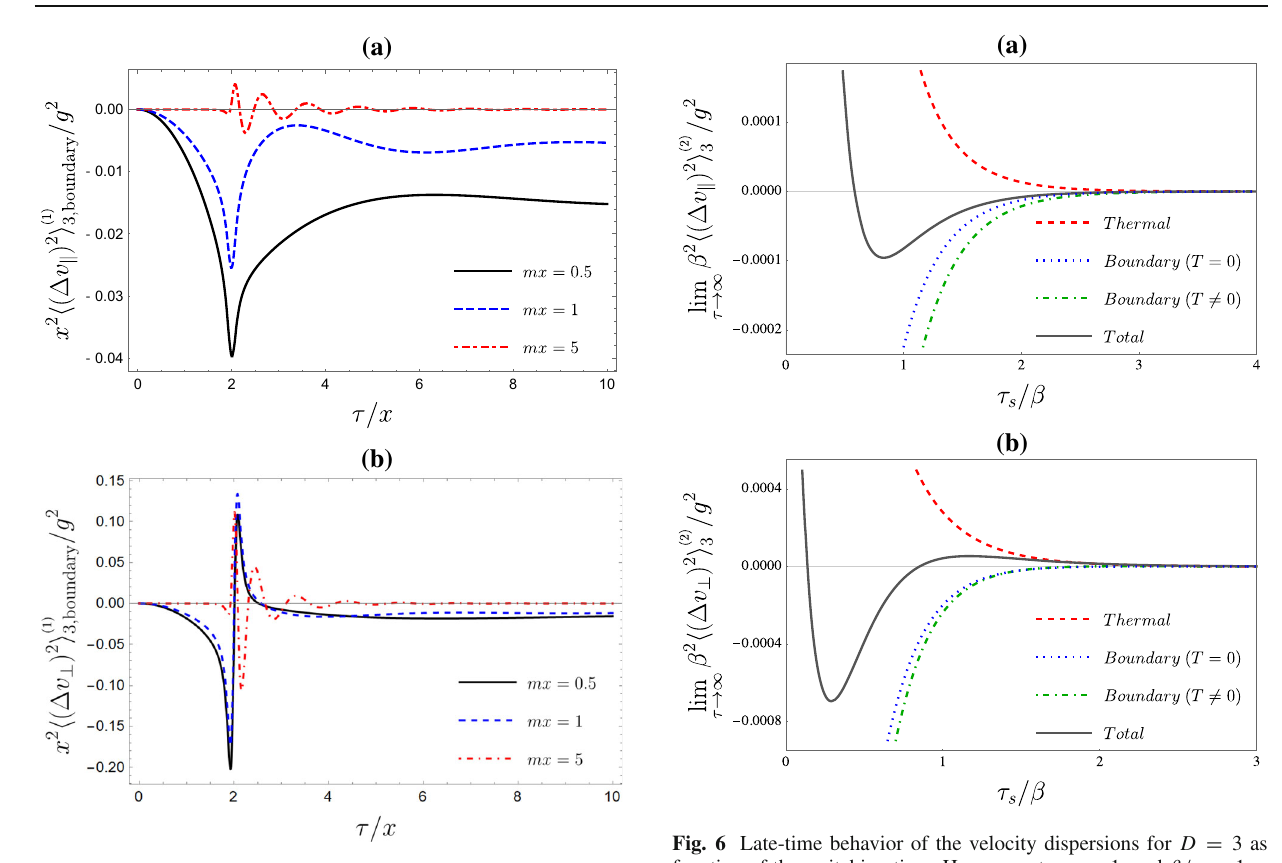
Fig. 5 Dispersioncausedbyareflectiveboundary atfinitetemperature for D = 3. We set n = 20 and β/ x = 1. a Velocity dispersions in the paralleldirections. b Velocitydispersionsintheperpendiculardirection. As the field mass increases, the modified vacuum dominates over the finite temperature contribution